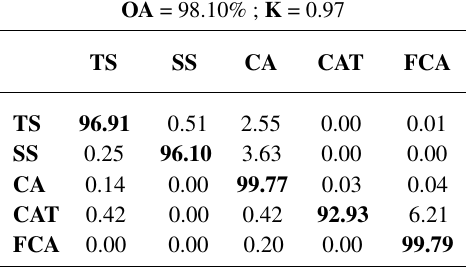
Table 15. Confusion matrix